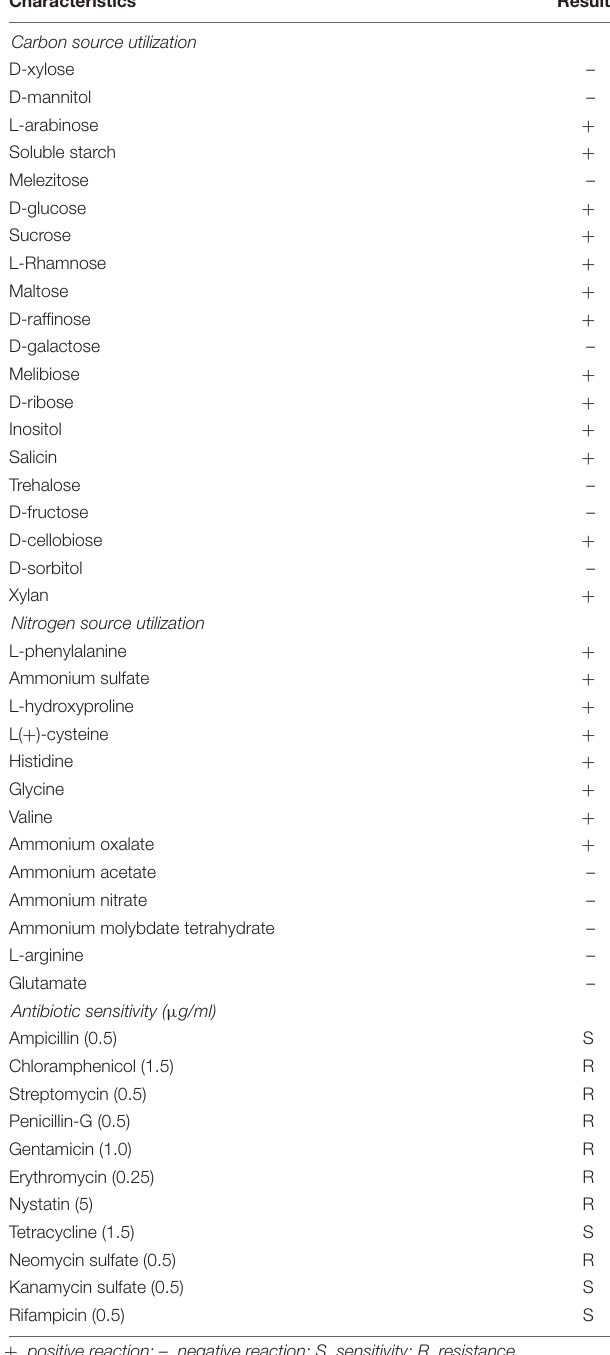
TABLE 2 | Morphological, physiological, and biochemical characteristics of strain SCA3-4.